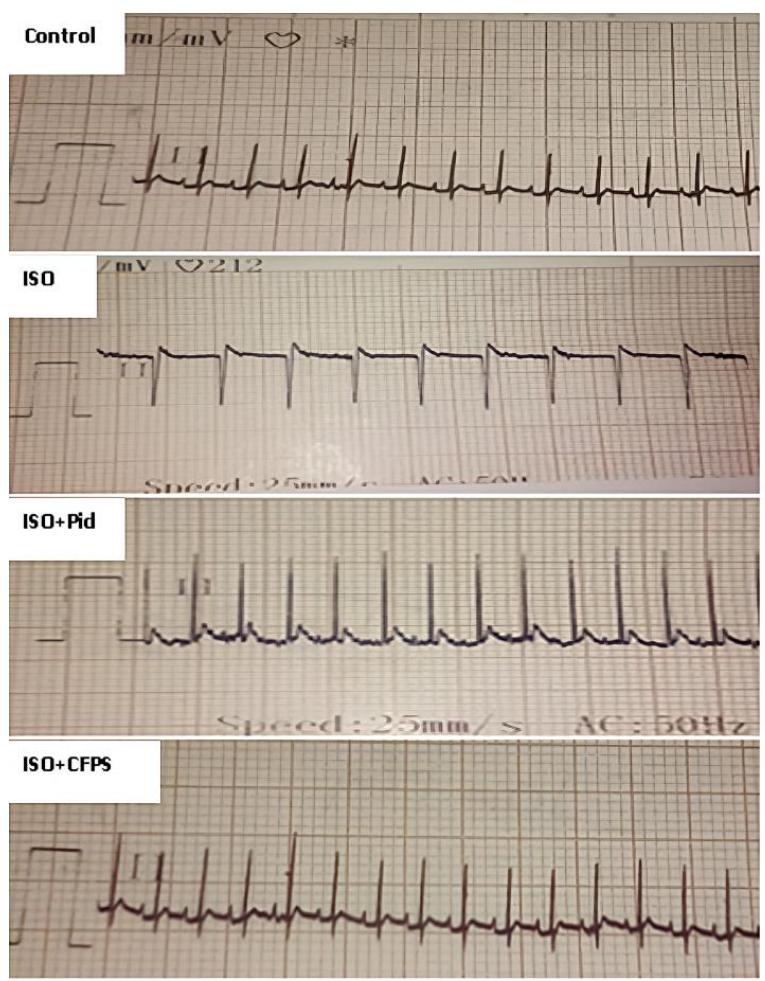
Figure 3. Effect of CFPS on electrocardiographic (ECG) pattern in treated animals. Control: recording of the control rats. ISO: recordings of the rats injected with isoproterenol (85 mg/kg). ISO + Pid: recording of rats precotreated with pidogrel (Pid) and injected with isoproterenol. Iso + CFPS: recording of rats precotreated with CFPS and injected with isoproterenol.